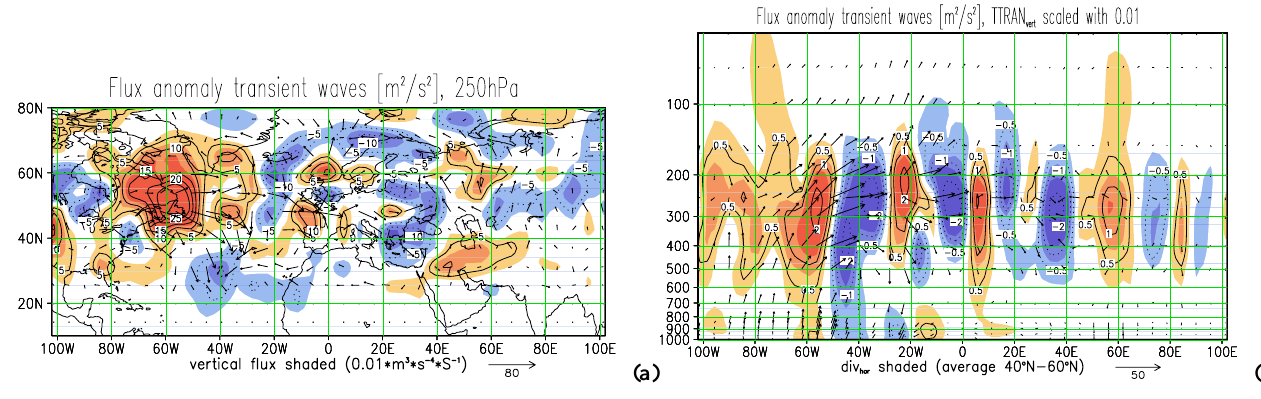
Fig. 7. Transient flux changes over the North Atlantic. Transient flux changes (Trenberth, 1986) over the North Atlantic due to the ozone anomaly for a high-pass filtered flow (2–6